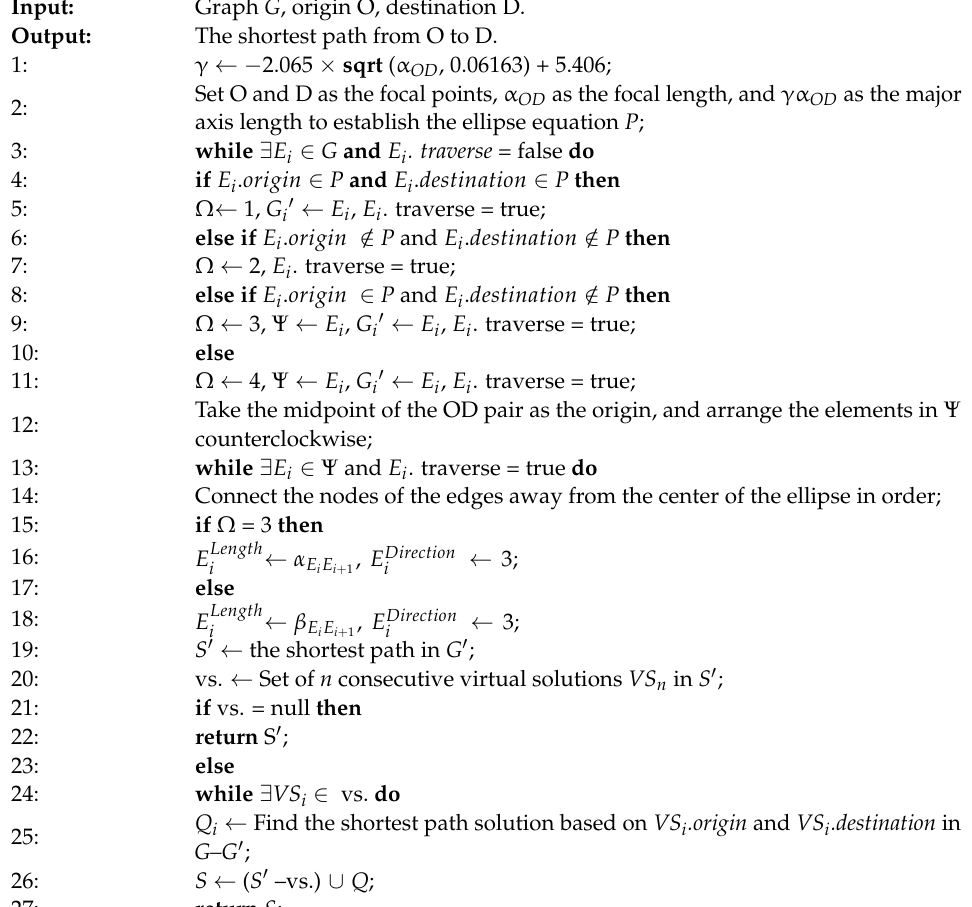
Algorithm 2 The Shortest Path Algorithm based on Virtual Boundary in Dynamic Ellipse